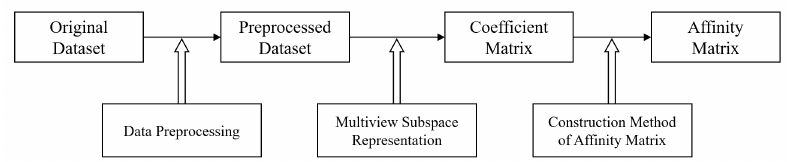
Figure 5. The flow of low-rank tensor-constrained multiview subspace representation